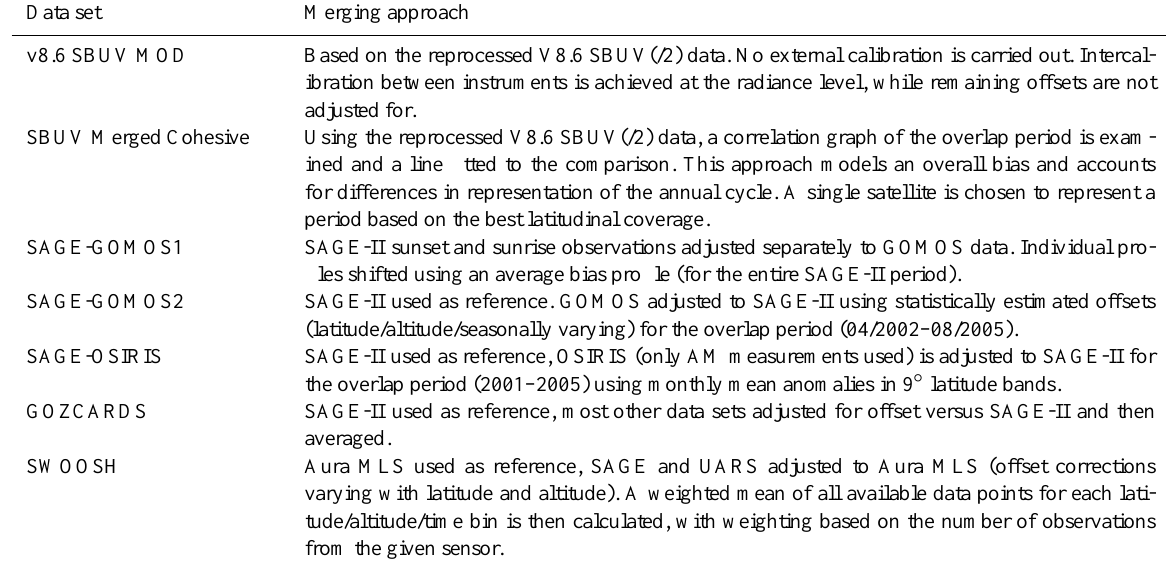
Table 4. Summary of the merging approaches used for each of the seven data sets.